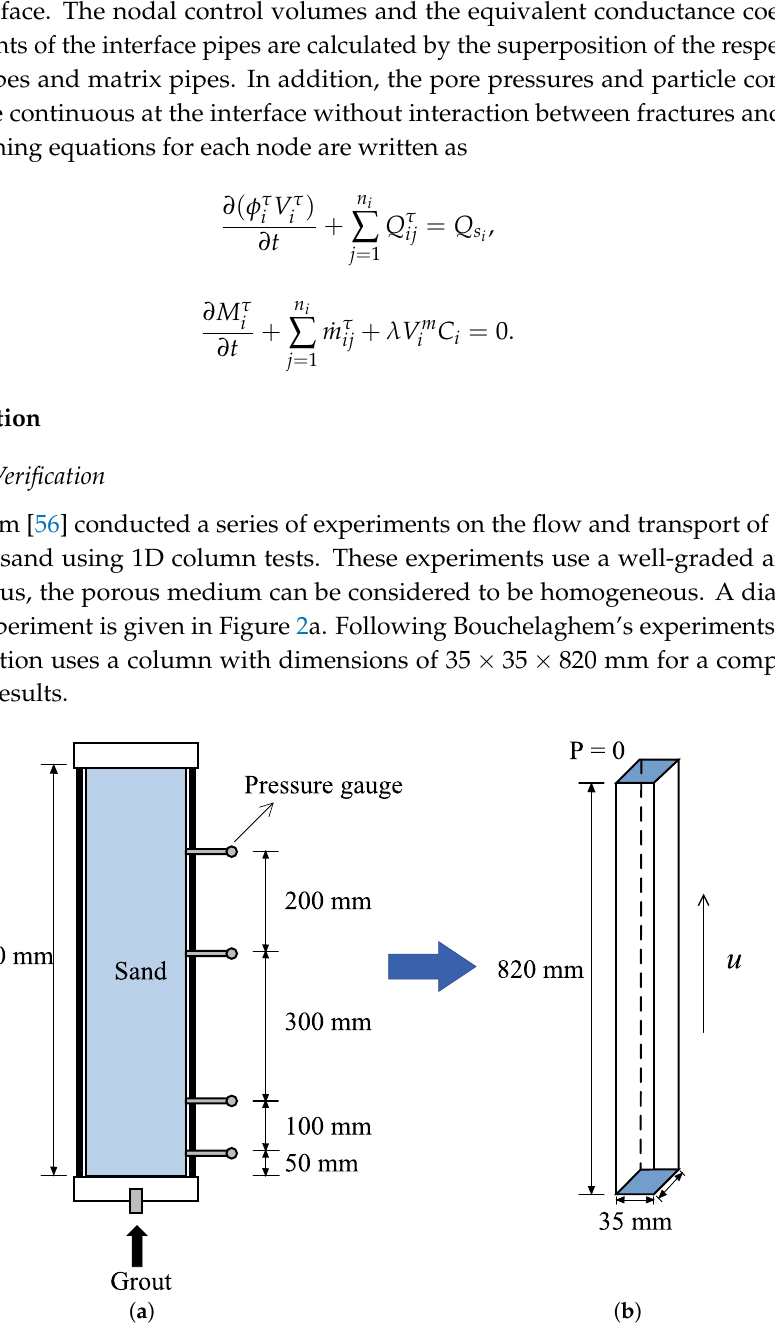
Figure 2. A schematic of grouting in sand. ( a ) 1D column injection test [56]; ( b ) the numerical verification